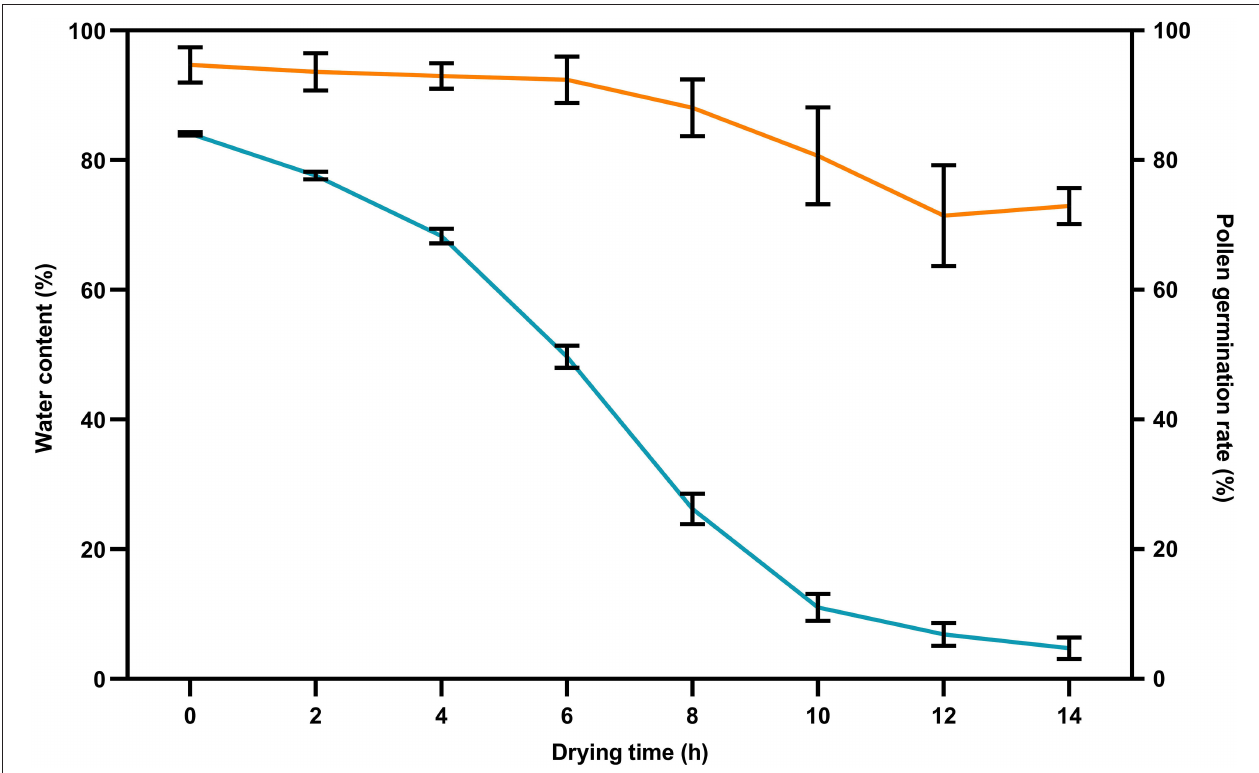
FIGURE 4 | Water contents of flowers and germination rates of pollen at different drying times. The flowers of Heihe43 at the initially-open stage were collected and dehydrated in the drying oven. All data were represented as mean ± SD of three replications.